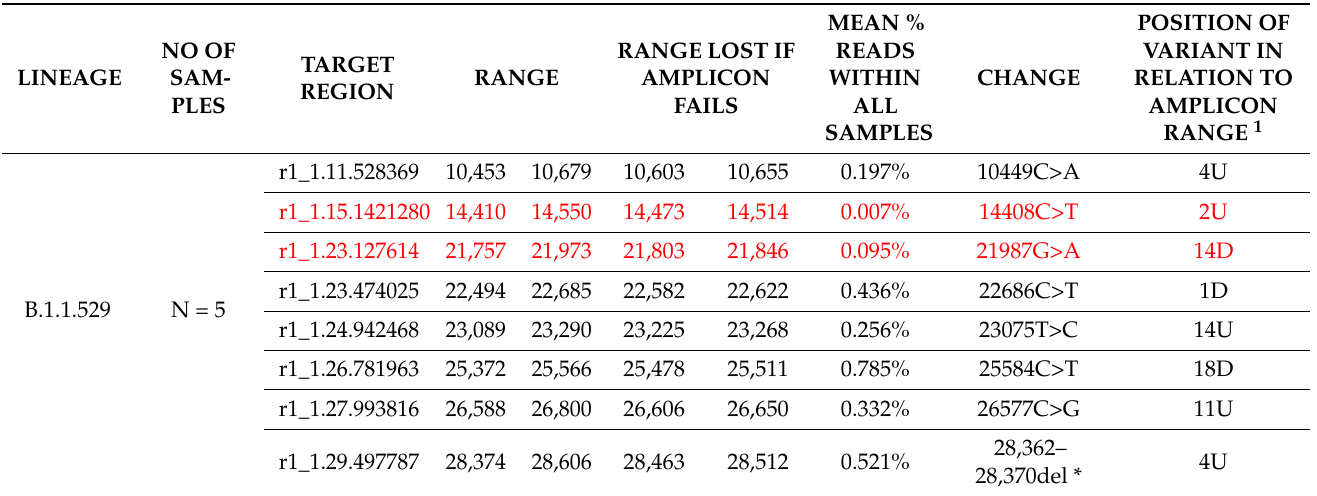
Table 5. Prediction of amplicons with low mean percentage of reads within total sample’s reads